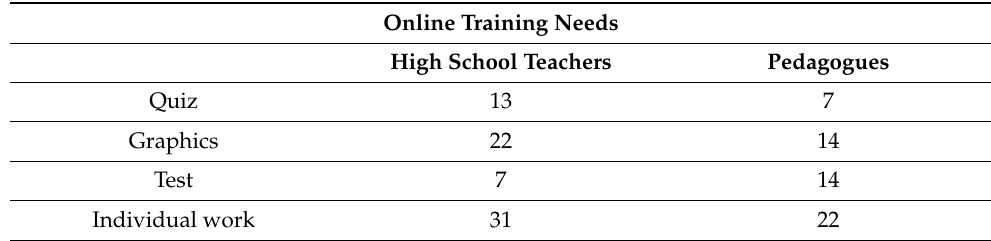
Table 7. Teachers’ and professors’ online